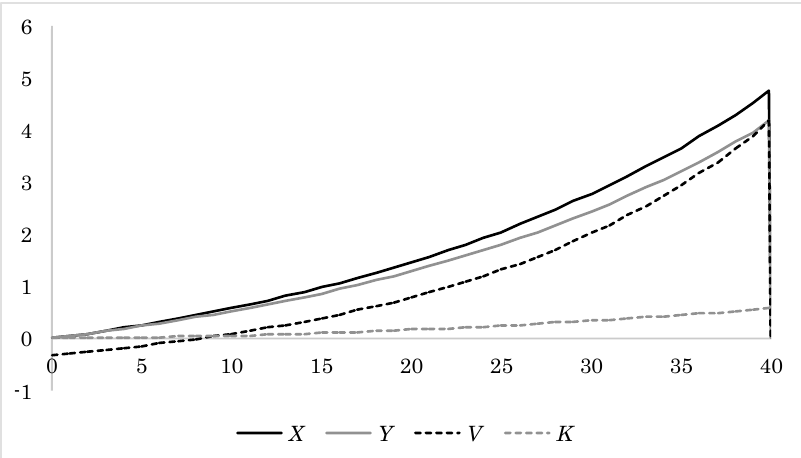
Figure 4. Approximated expected assets X , technical reserve Y , market reserve V and collective bonus potential K as a function of